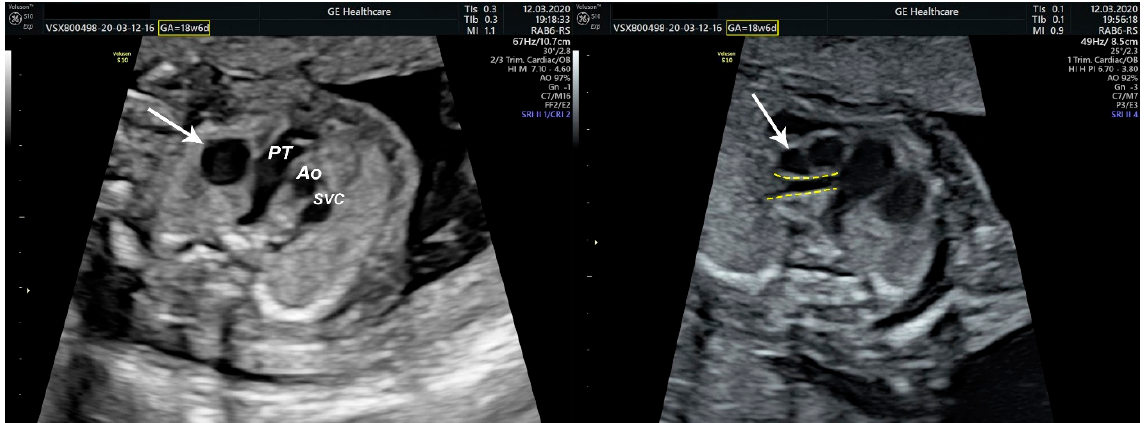
Figure 1. ( Left ): normal triphasic flow of the ductus venosus; ( middle ): mild cardiomegaly and a common four-chamber aspect of the heart; ( right ): membranous ventricular septal defect.